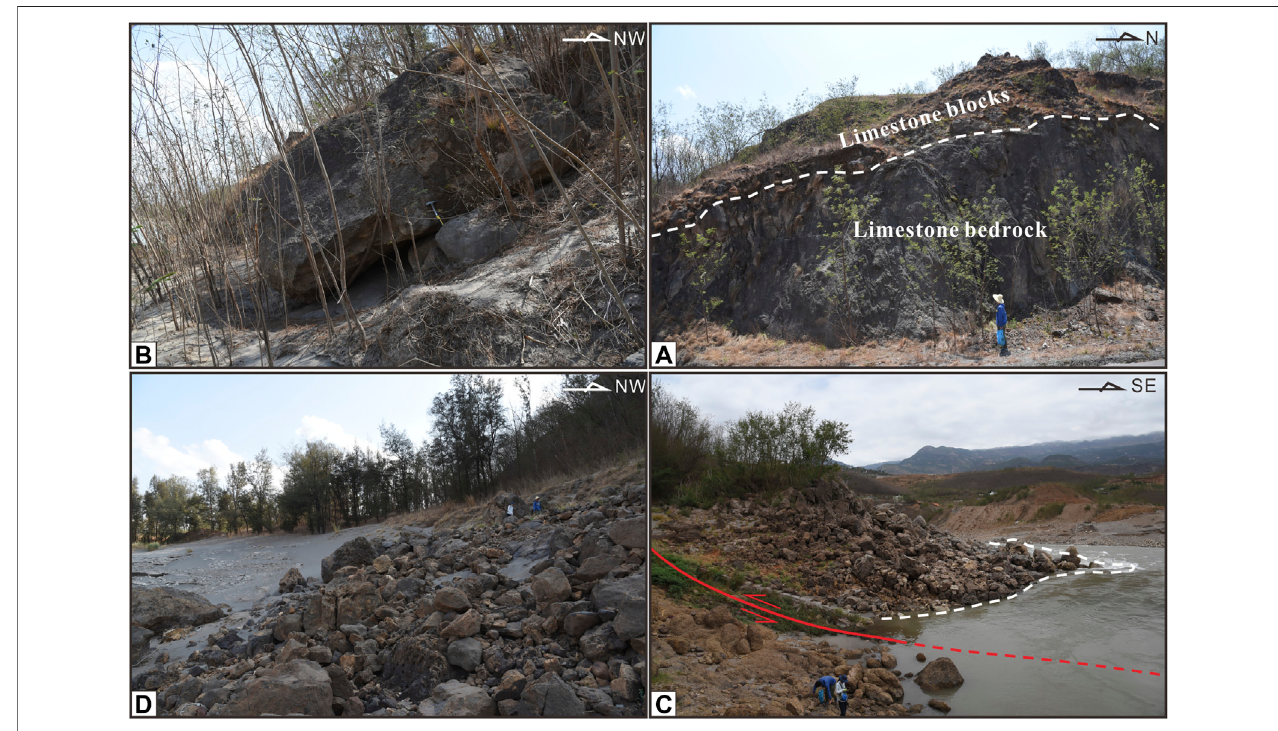
FIGURE 9 | (A) and (B) limestone boulders from the rock falls at sections (B) and (C) ; (C) Field view of the dam at the north side of Qiaojia Segment; (D) limestone boulders scatter on the west bank of the Jinsha River from the rock fall at section (D) . All locations in Figure 7 .